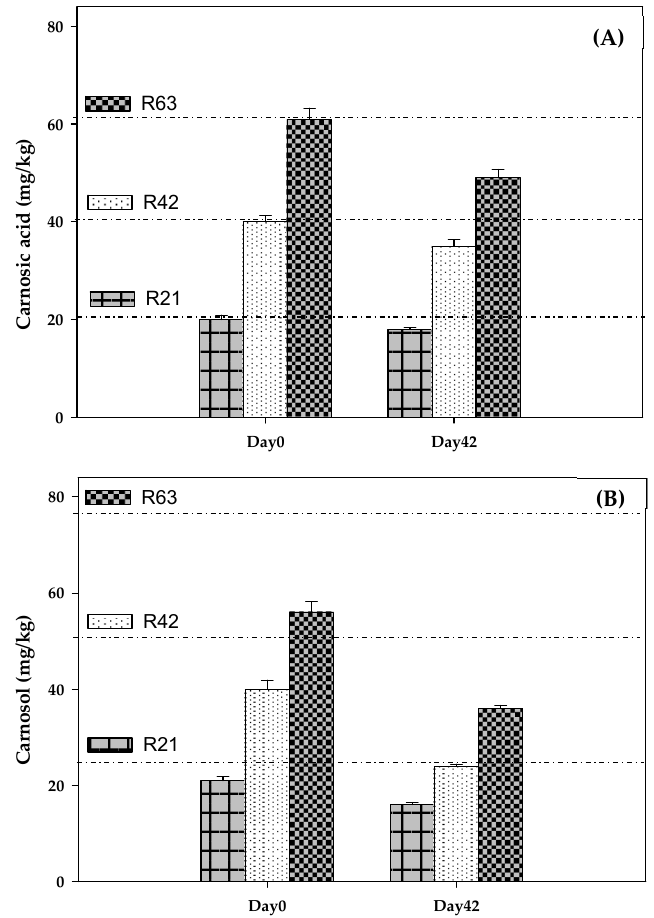
Figure 1. Carnosic acid ( A ) and carnosol ( B ) content (mg/kg) of salmon pâté. Abbreviations: R21/42/63: rosemary lipophilic extract at different doses.